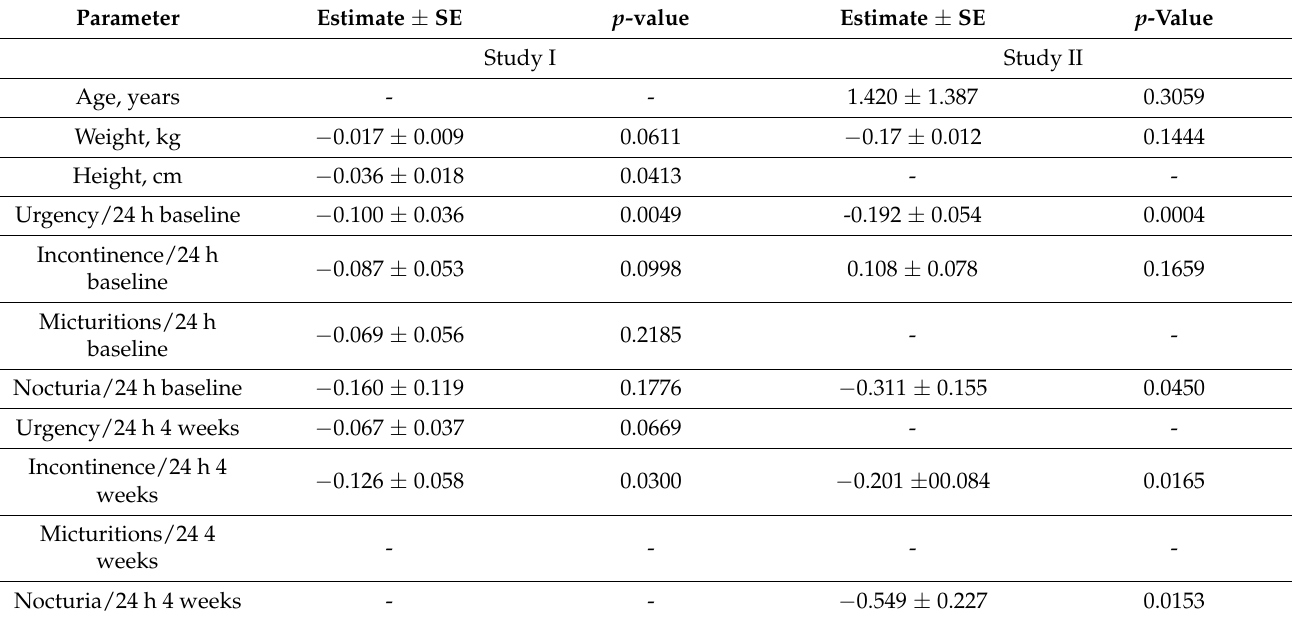
Table 4. Factors associated with staying at the starting dose of 30 mg vs. increasing to a dose of 45 mg in a logistic regression analysis taking both OAB parameters at baseline and after 4 weeks into